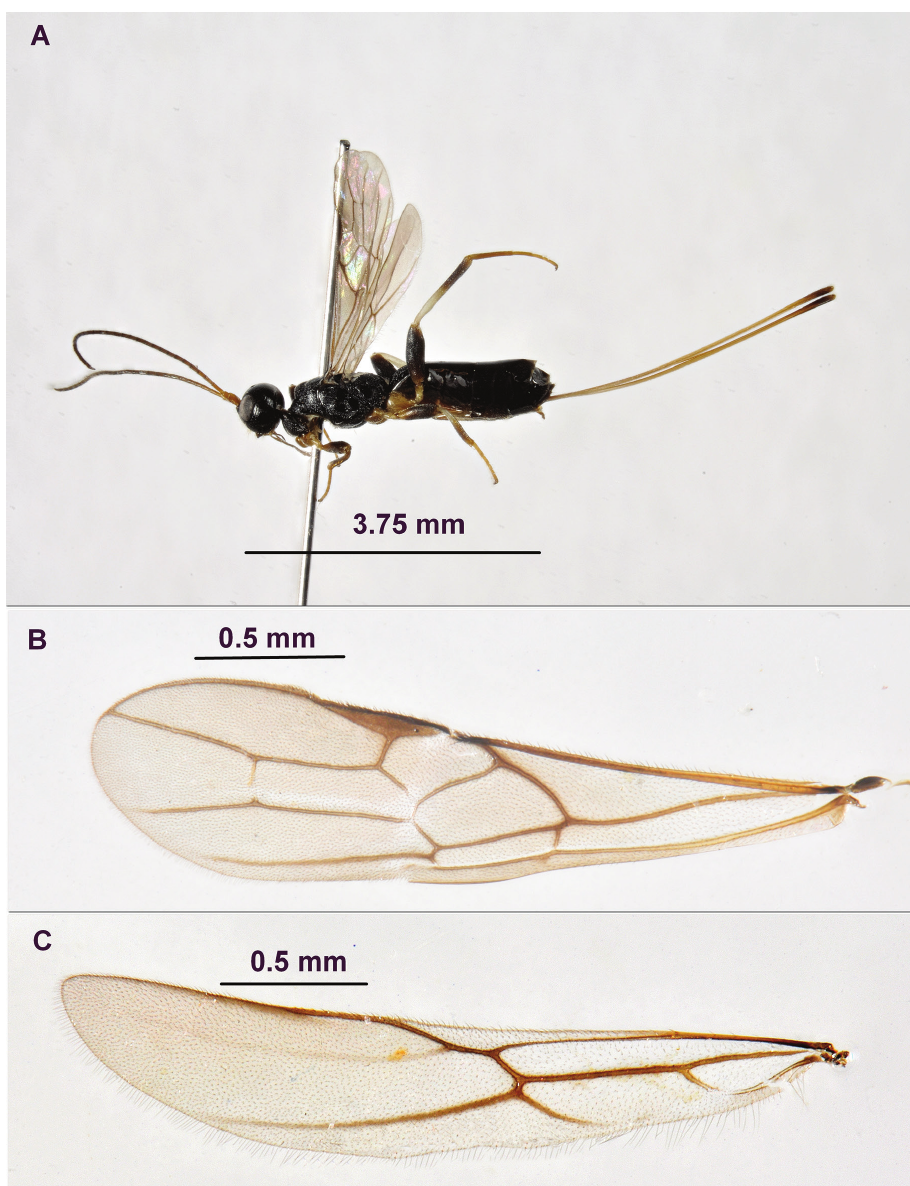
Figure 1. Rhoptrocentrus piceus Marshall: A habitus, lateral view B fore wing C hind wing.